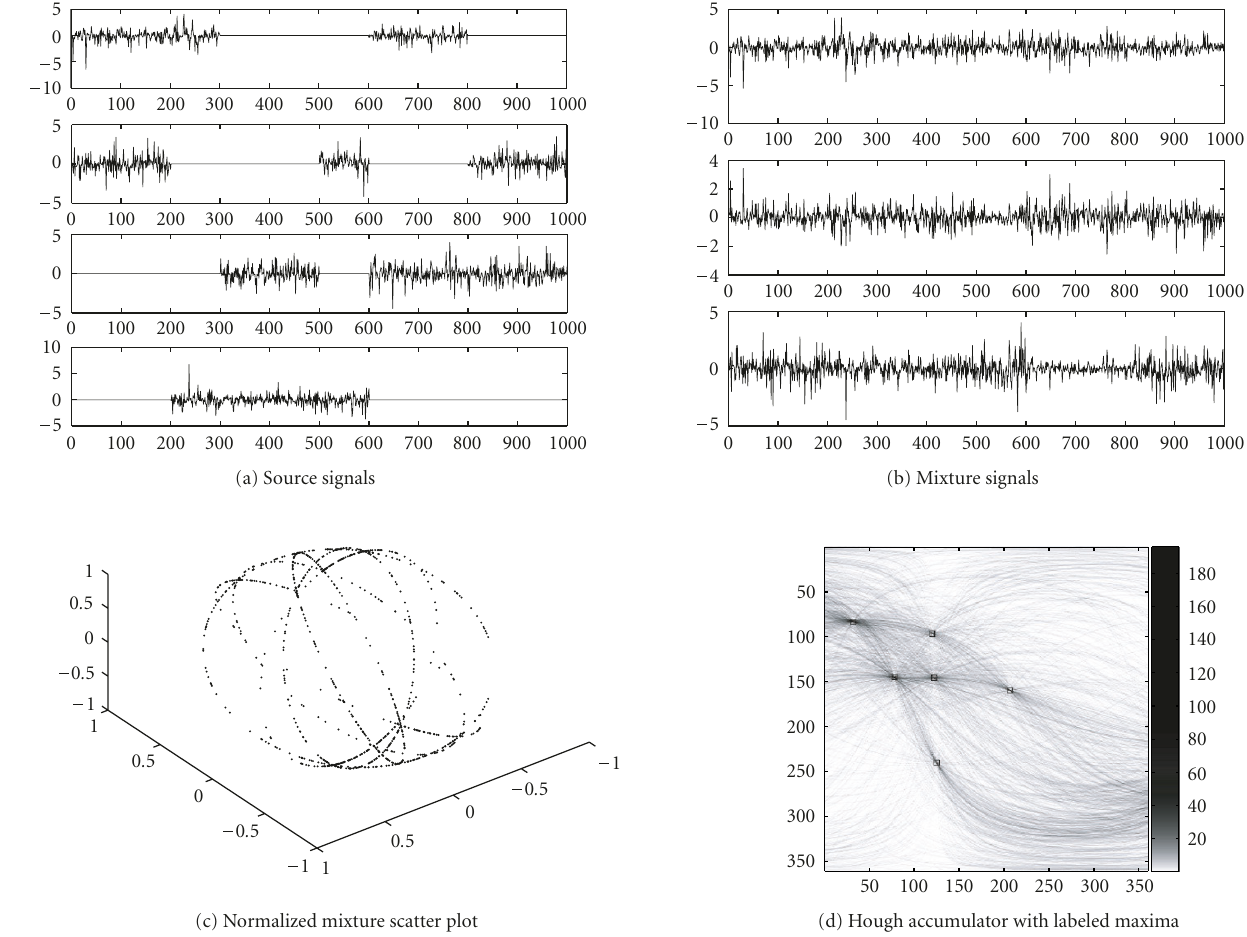
Figure 4: Example: (a) shows the 2-sparse, su ffi ciently rich represented, 4-dimensional source signals, and (b) the randomly mixed, 3- dimensional mixtures. The normalized mixture scatter plot { x ( t ) / | x ( t ) | | t = 1, ... , T } is given in (c), and the generated Hough accumulator in (d); note that the color scale in (d) was chosen to be nonlinear ( γ new : = (1 − γ/ max) 10 ) in order to visualize structure in addition to the strong